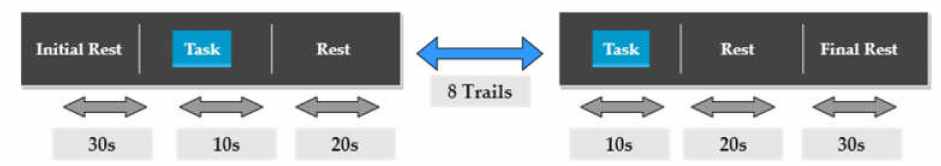
Figure 3. Experimental paradigm with experimental 10 trials with initial and final 30 s rest.